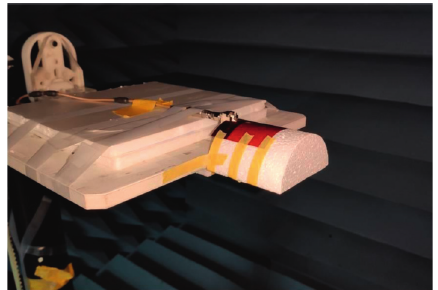
Figure 18: Photograph of the folding of the antenna under test for far-field